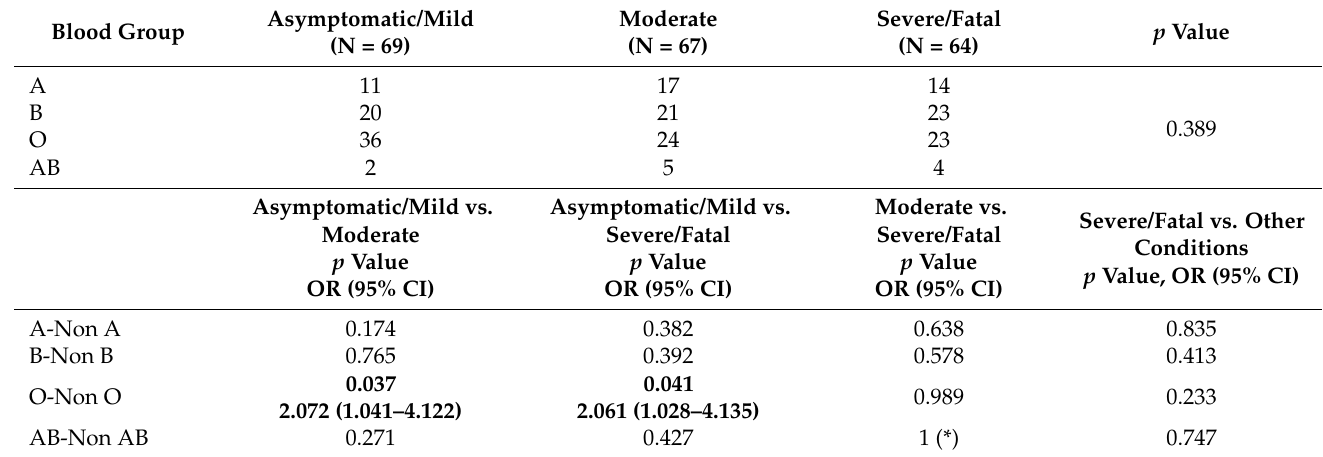
Table 3. Comparison of ABO blood group between the patient